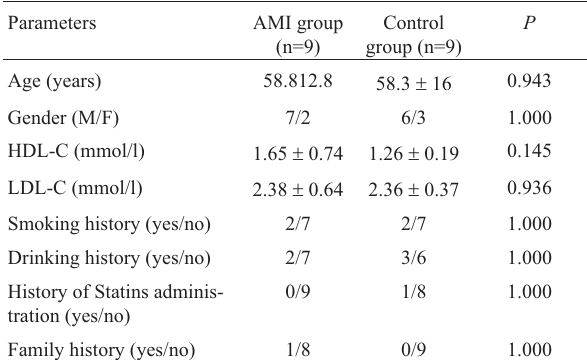
Table 3 - Baseline information of the study subjects for real-time fluores- cence quantitative PCR